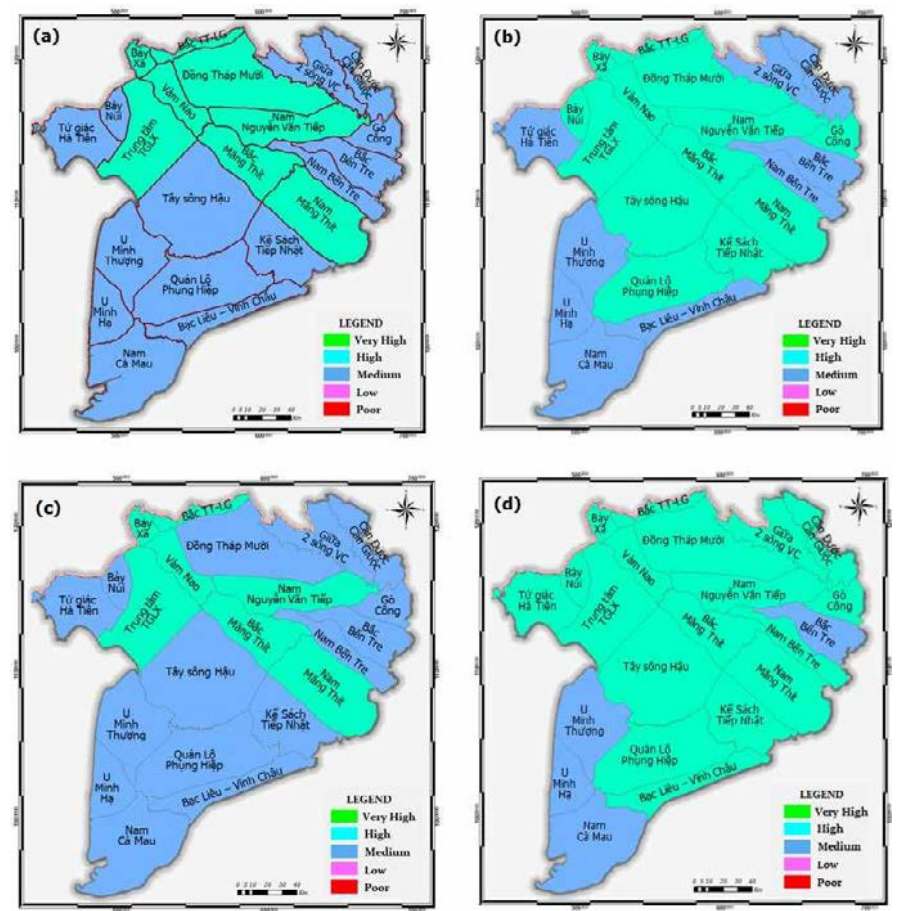
Fig. 5: (a) Overall water security index in 2018; (b) Overall water security index in the 2018 flood season; (c) Overall water security index for the 2018 dry season; (d) Overall water security index in 2018 (based on the methods of Mui, 2018; Babel et al ., 2022 )